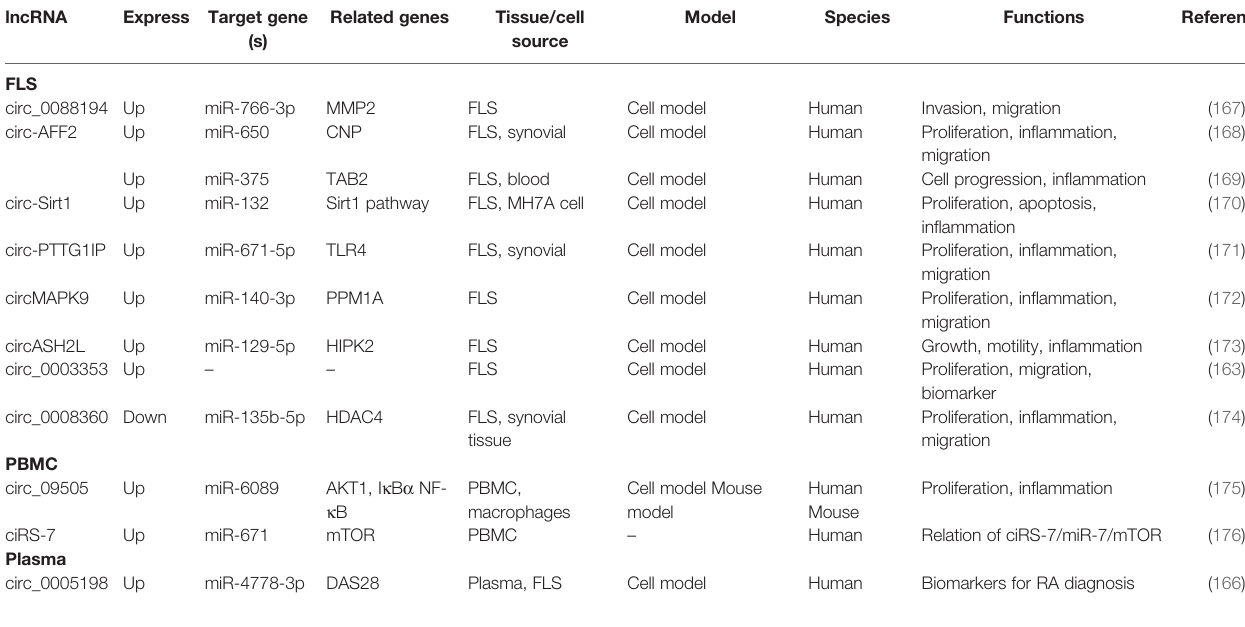
TABLE 5 | The aberrantly expressed circRNAs in